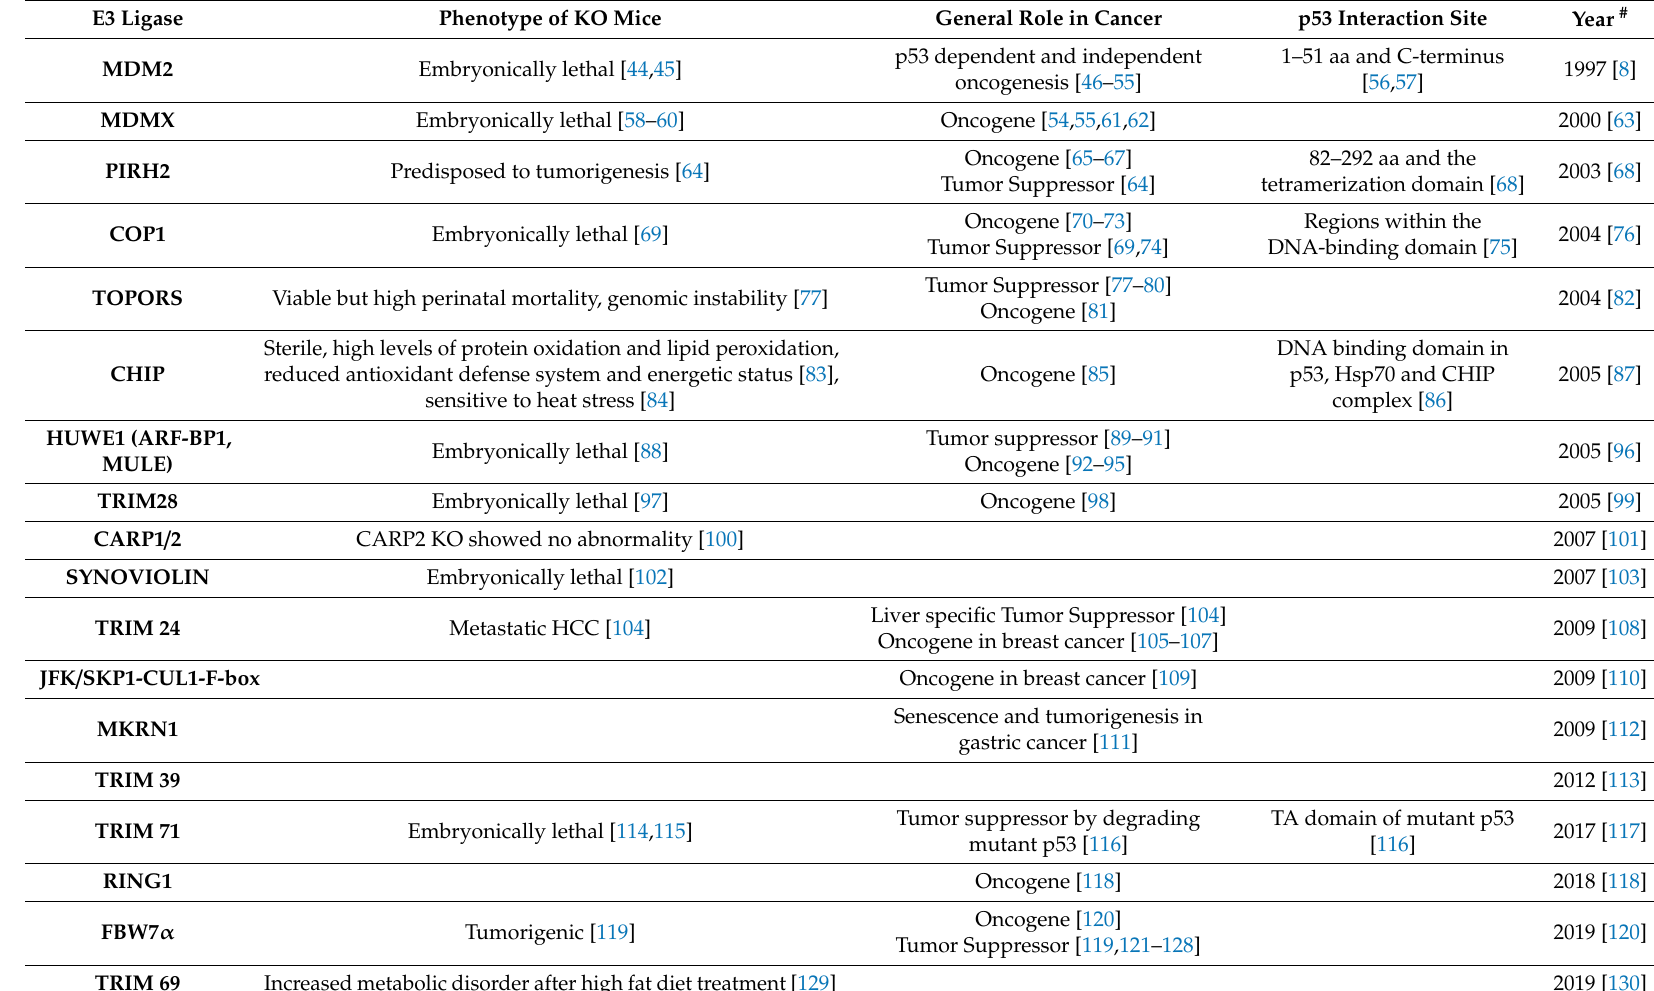
Table 1. Ubiquitin E3 ligases That Directly Promote the Degradation of p53